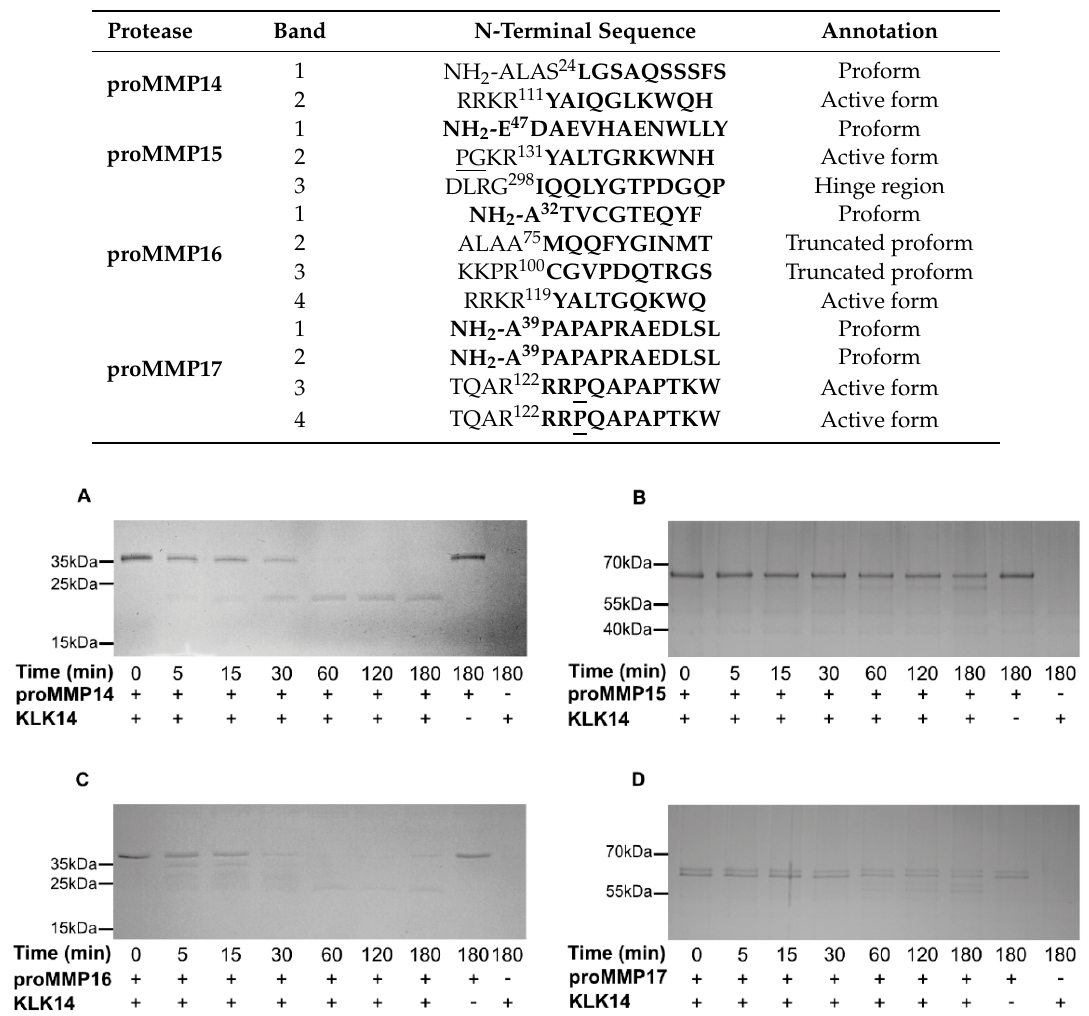
Table 2. N-terminal identification of KLK14-mediated processing of recombinant proMMPs. The KLK14 hydrolysis product sequences were analyzed by N-terminal sequencing using Edman degradation. The bold font denotes the amino acid sequences identified. The underscored residues represent changes to the native protein sequence, as reported by the manufacturer (R&D Systems, Abingdon, United Kingdom). KLK14 recognized the sequence 3-aa upstream of the native MMP17 activation site, likely because the native site was modified by the manufacturer. All residues are numbered according to the Uniprot reported sequence of the full-length proteins. Bands are labeled according to the notation explained at Figure 2.